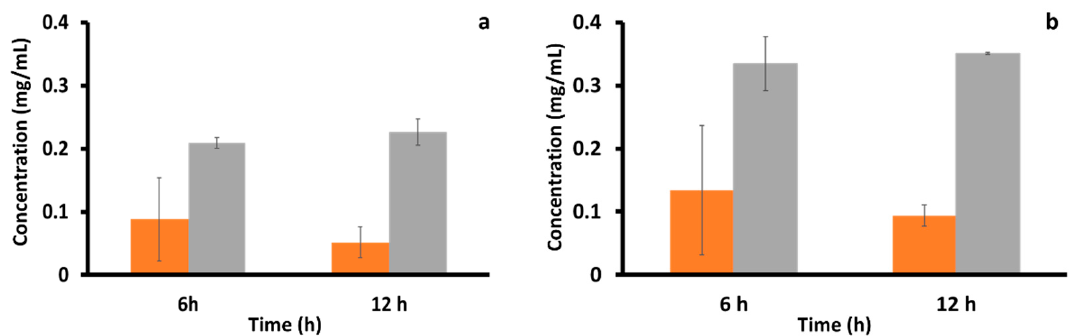
Figure 7. Quercetin liberation at different pH. ( a ) pH 6.5 and ( b ) pH 7.5.